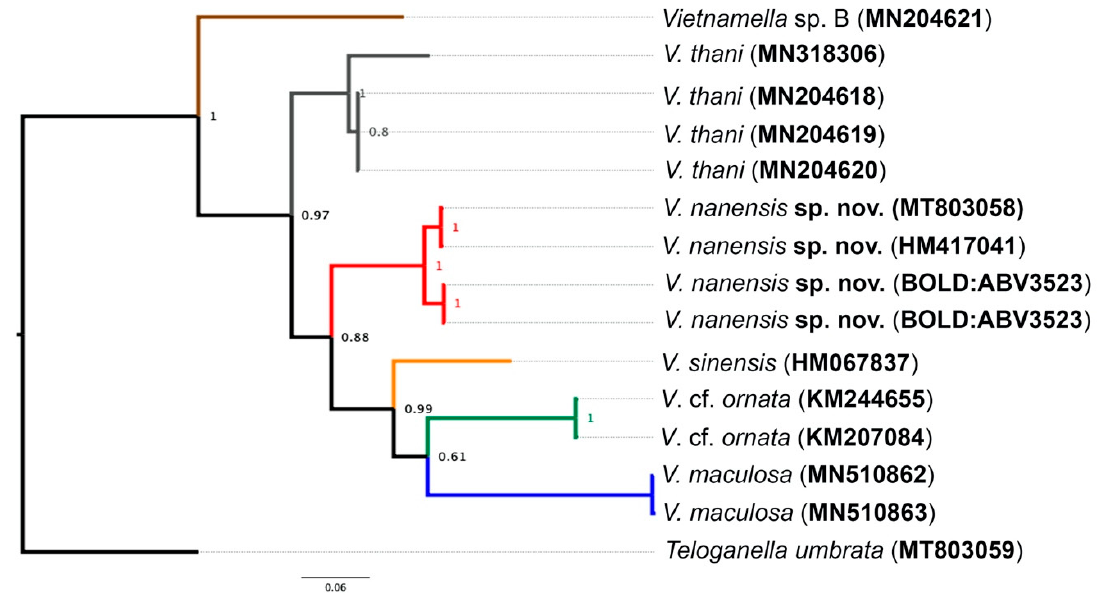
Figure 9. Bayesian interference of Vietnamellidae. The COI phylogenetic reconstruction of six different species of Vietnamella with the branch probability support. The accession number of GenBank or Barcode Index Number (BIN) of Barcode of Life Data System (BOLD) in brackets. Teloganella umbrata was used as the outgroup.